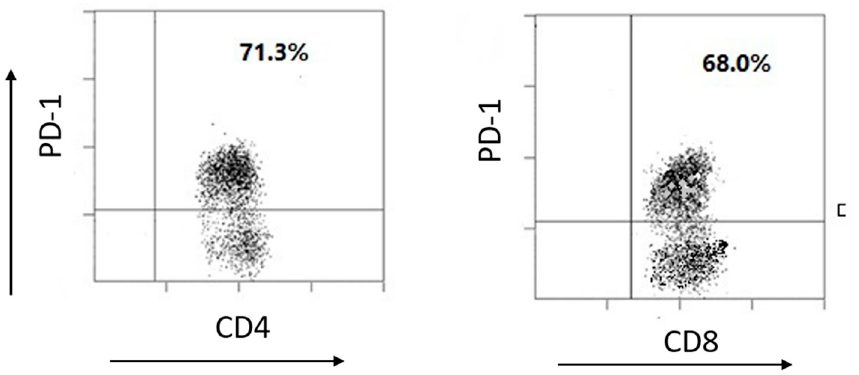
Figure 4. PD-1 expression in human tumor infiltrating lymphocytes (TILs). FACS results show the PD-1 positive cells in CD4 and CD8 cell populations from TILs.